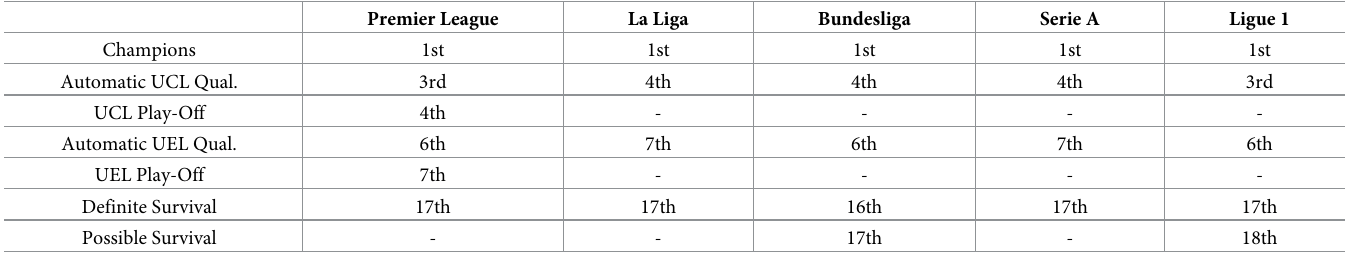
Table 1. League positions resulting in specific consequences for teams in each